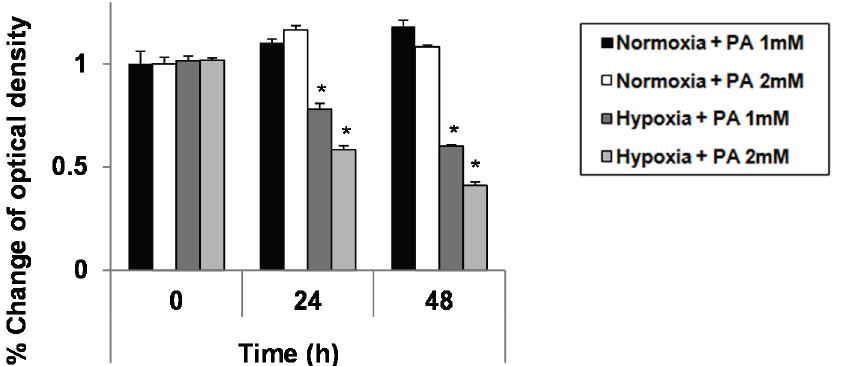
Figure 1. Enhanced palmitic acid (PA)-induced growth suppression in hypoxic hepatocytes. HepG2 cells grown under either standard culture conditions (20% O 2 and 5% CO 2 ; at 37 °C) or hypoxic culture conditions (1% O 2 , 5% CO 2 and 94% N 2 ; at 37 °C) were treated with 1.0 mM of PA. At each indicated time point, a 3,4-(5-dimethylthiazol-2-yl)-5-